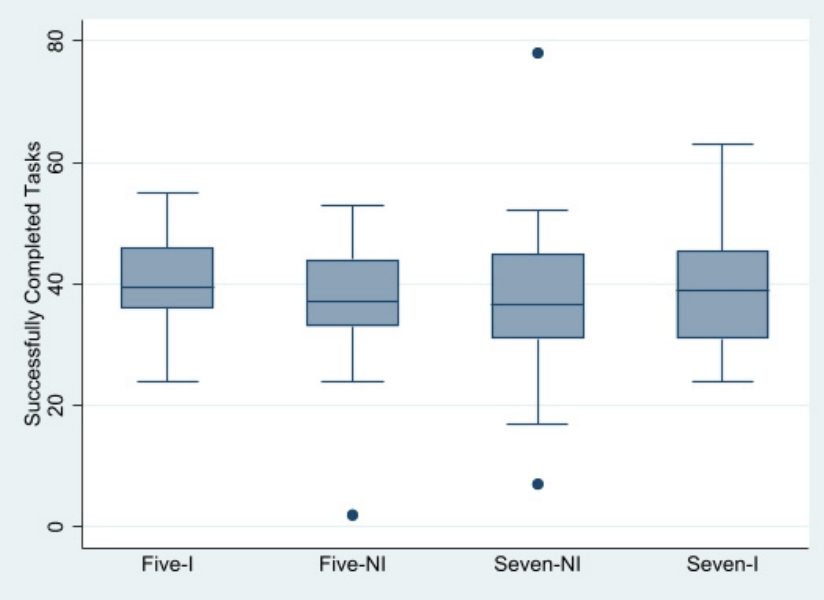
Figure 2. A box-whisker plot of subject effort during Task 1 by Treatment.